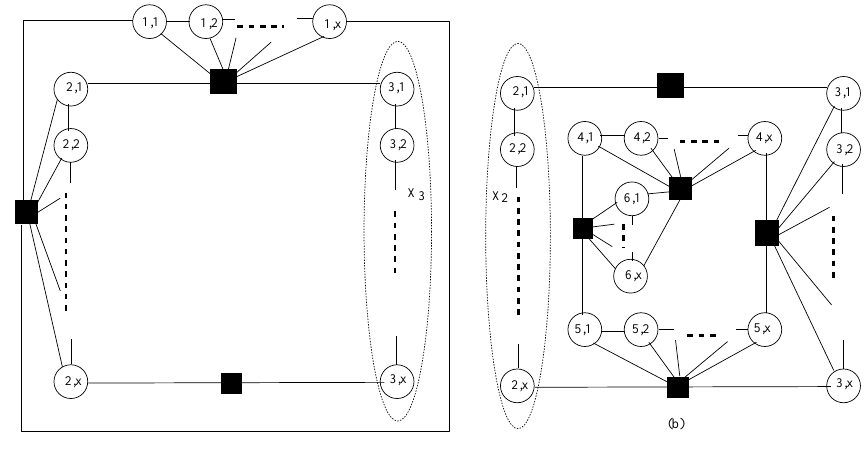
Figure 2. ( a ) Subgraph G [ U (0 , 2)] and ( b ) Subgraph G [ U (1 , 2)] of G